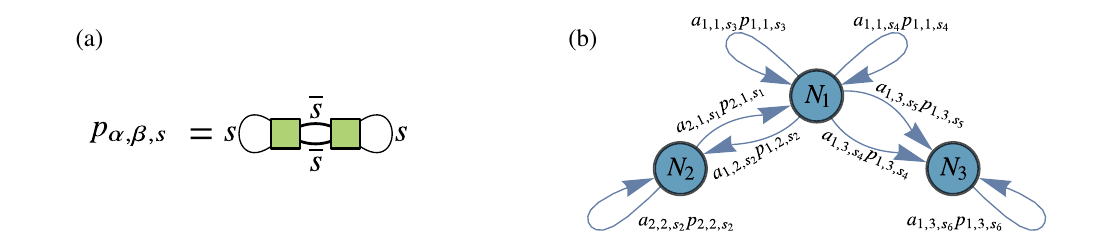
FIG. 10. (a) Schematic representation of the p α according to Eq. (B13). (b) Representative graph obtained after integrating the modules in the forward light cone L connected to the node N β via an (oriented) arrow. Each edge is associated with an operator e α